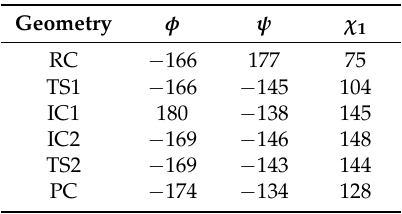
1 See Figure 1 for definitions of φ , ψ , and χ